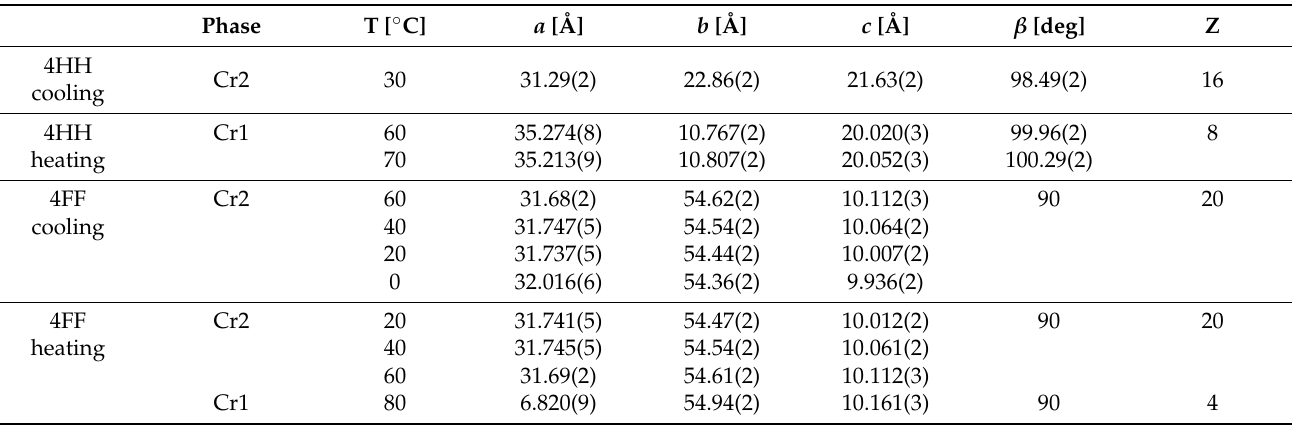
Table 2. Unit cell parameters of the crystal phases of 4HH and 4FF ( α = γ = 90 ◦ ). The representative Le Bail fitting results are presented in the Supplementary